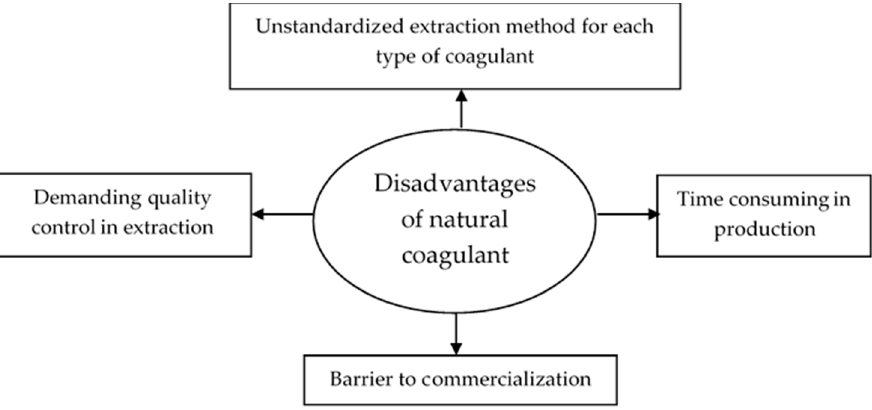
Figure 1. Disadvantages of utilising natural coagulant in microalgae harvesting.